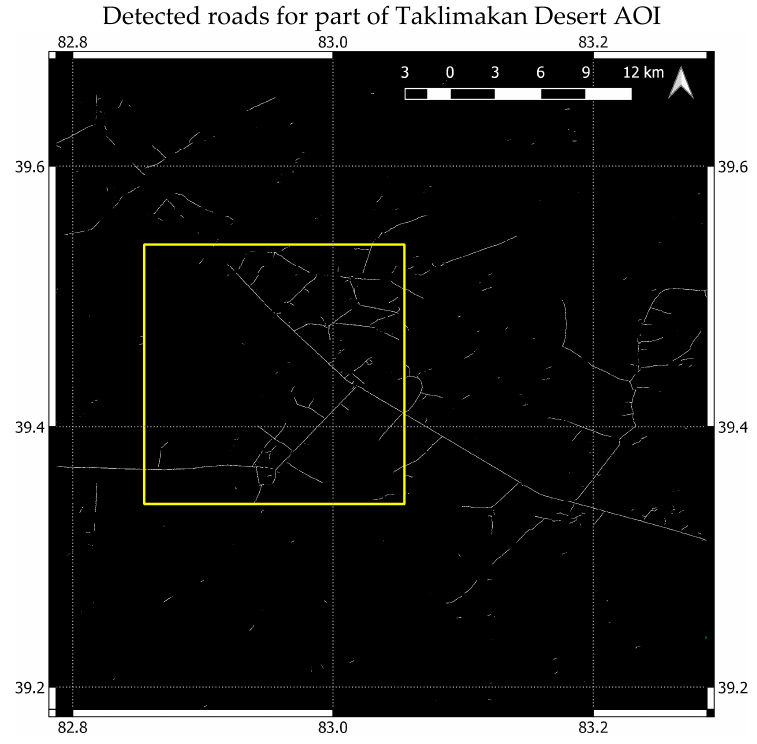
Figure 16. Detected roads for part of the Taklimakan Desert AOI. The yellow rectangle shows a 0.2 × 0.2 degree subset over which roads were manually digitised and a performance evaluation carried out. This area is shown in more detail in Figure 17.